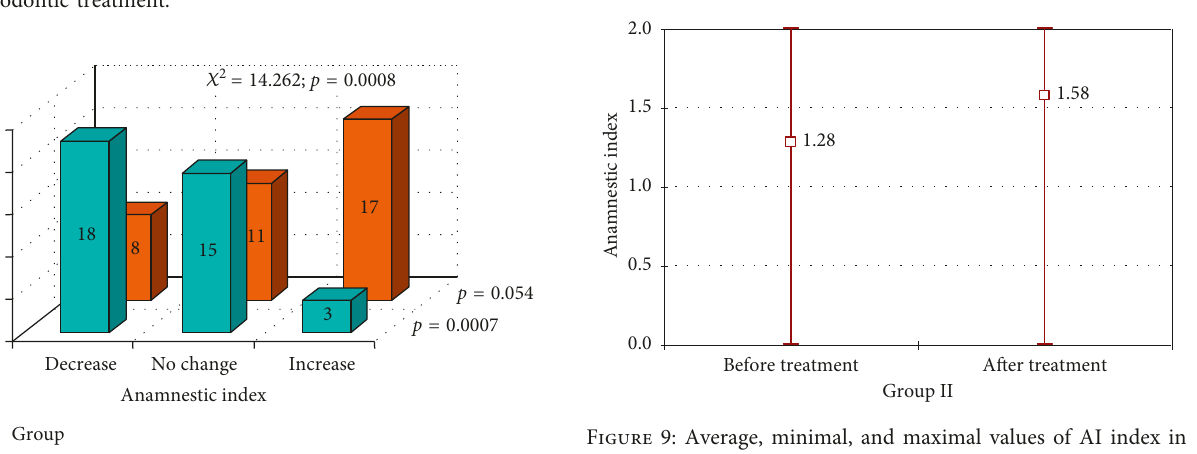
Figure 6: Anamnestic index (AI) in both groups I and II after the prosthodontic treatment.